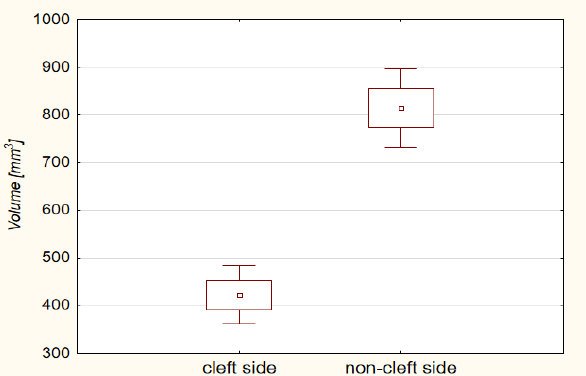
Figure 2. Box and whisker plot presenting the means, means ± standard deviations and means ± 1.96 × standard deviations of the cleft-side alveolar bone volume and the non-cleft side alveolar bone volume. The difference between the volumes was statistically significant ( p < 0.0001, Student’s t - test).